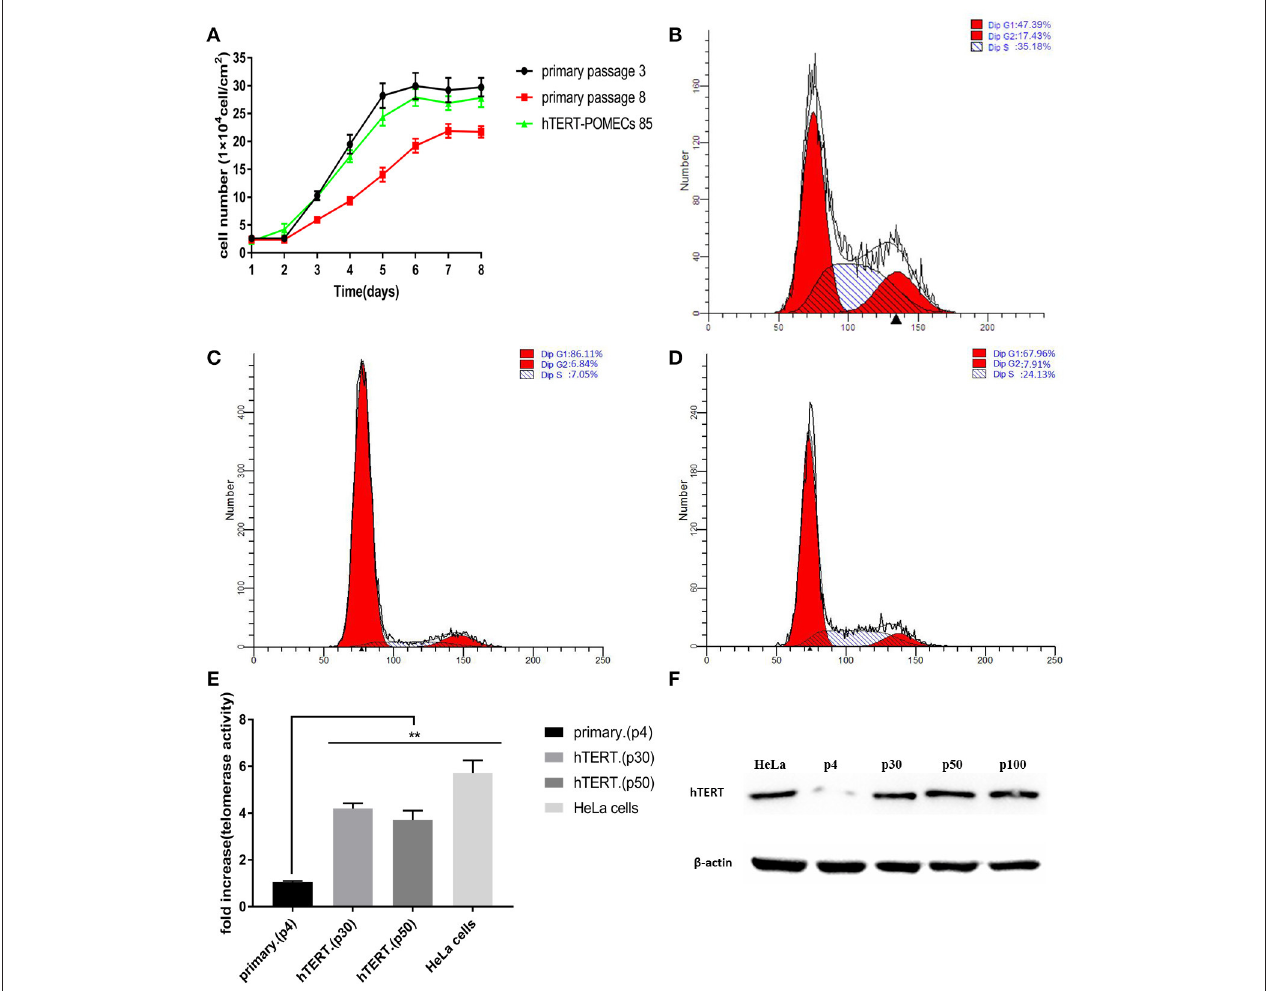
FIGURE 3 | Enhanced proliferation and increased telomerase activity in hTERT-POMECs. (A) Growth kinetics of 3rd and 8th passage POMECs and 85th passage hTERT-POMECs. (B–D) Cell cycle analysis of 3rd and 8th passage POMECs and 85th passage hTERT-POMECs. The percentages of 3rd and 8th passage POMECs and 85th passage hTERT-POMECs in S phase were 35.18, 7.05, and 24.13%, respectively. (E) Telomerase activity in 4th passage POMECs and 30th and 50th passage hTERT-POMECs. HeLa cells served as a positive control. The data were means ± SEM values of three independent experiments. ** P < 0.01 vs. fourth passage POMECs. (F) Expression of hTERT protein was detected by western blotting. hTERT protein was positively detected in 30th, 50th, and 100th passage hTERT-POMECs, but not in fourth passage POMECs. HeLa cells served as a positive